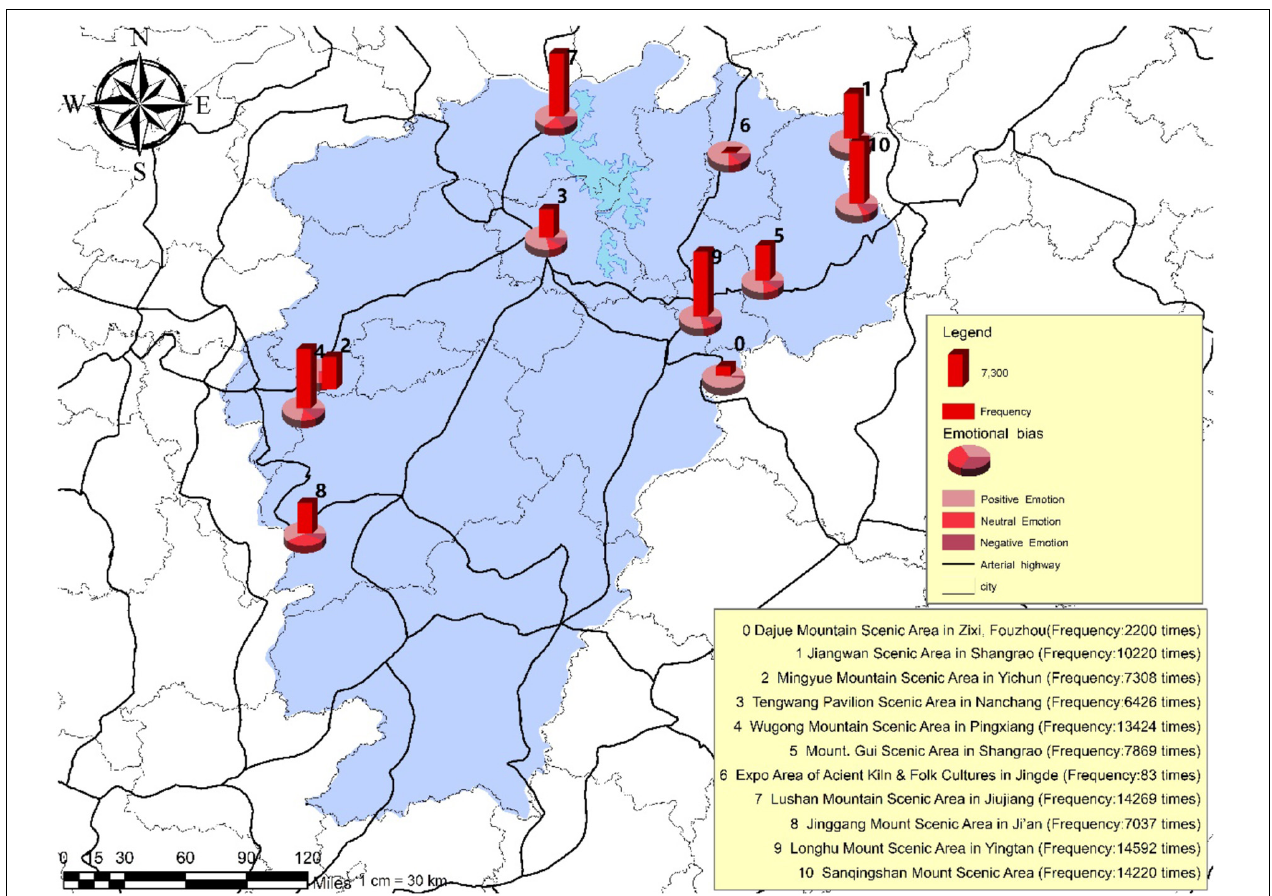
FIGURE 7 | The arterial highway point and line links of tourism destinations in the space and time dimension.